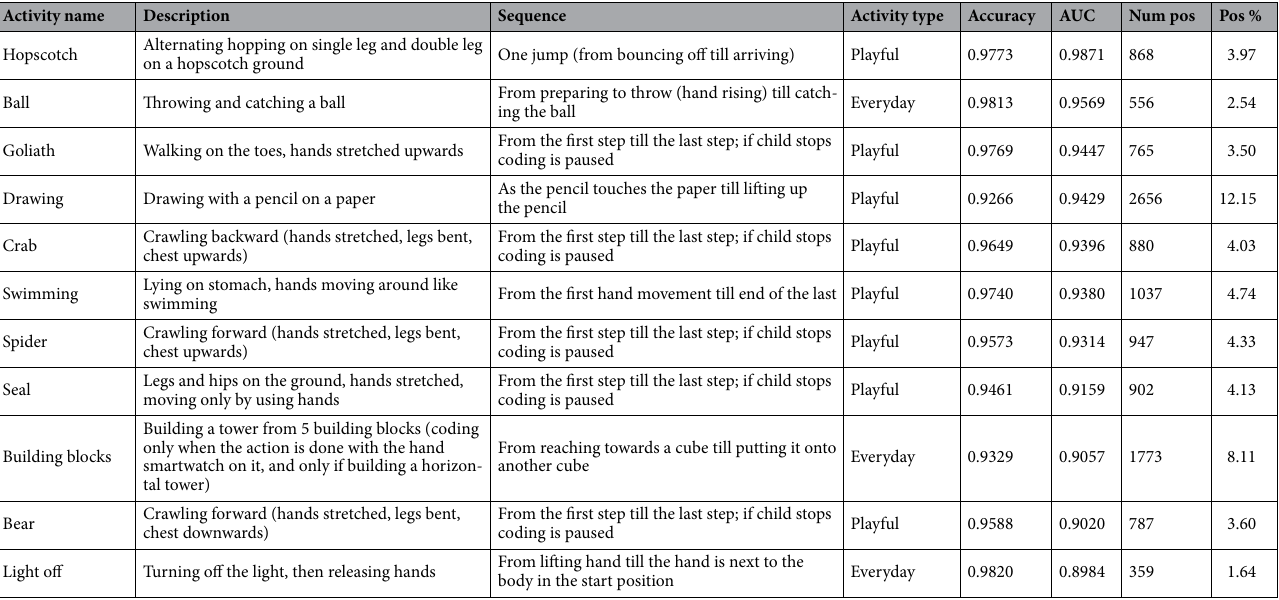
Table 1. The Budapest activity test battery (BATB) and performance of the machine learning methods. The table was sorted by AUC with the highest recognition figures at the top. Num pos is the number of occurrences of a given activity in the dataset.